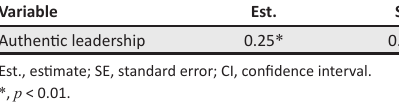
TABLE 5: Indirect effects of authentic leadership on work engagement via trust in supervisor. Variable